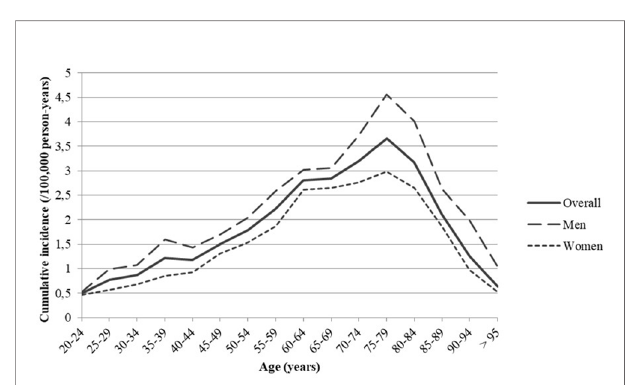
FIGURE 3 | Cumulative incidence of Chronic Myeloid Leukemia (CML) in France during the period 2011-2014 by age and